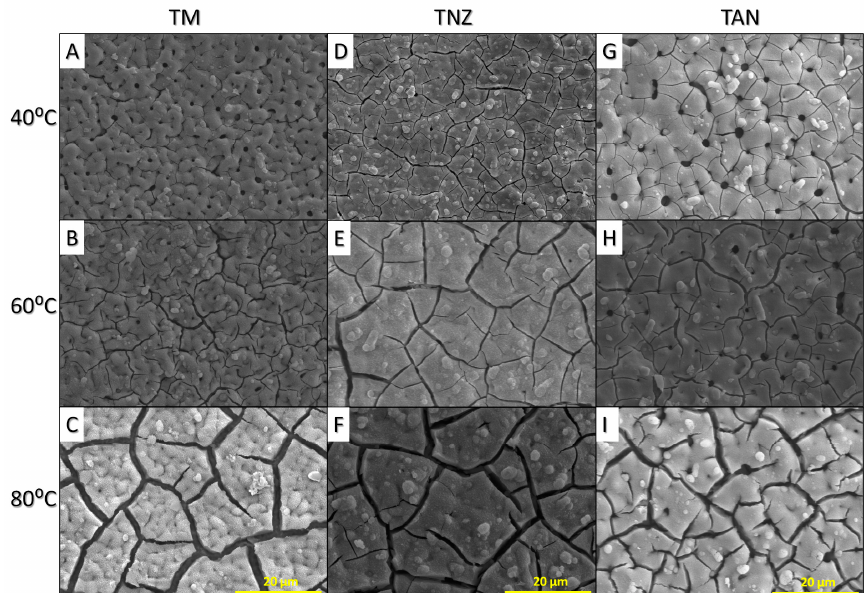
Figure 5. SEM images of the titanium TM ( A – C ), TNZ ( D – F ), TAN ( G – I ) alloy samples after anodization and immersion in 5 M KOH at various temperatures, for 8 h.